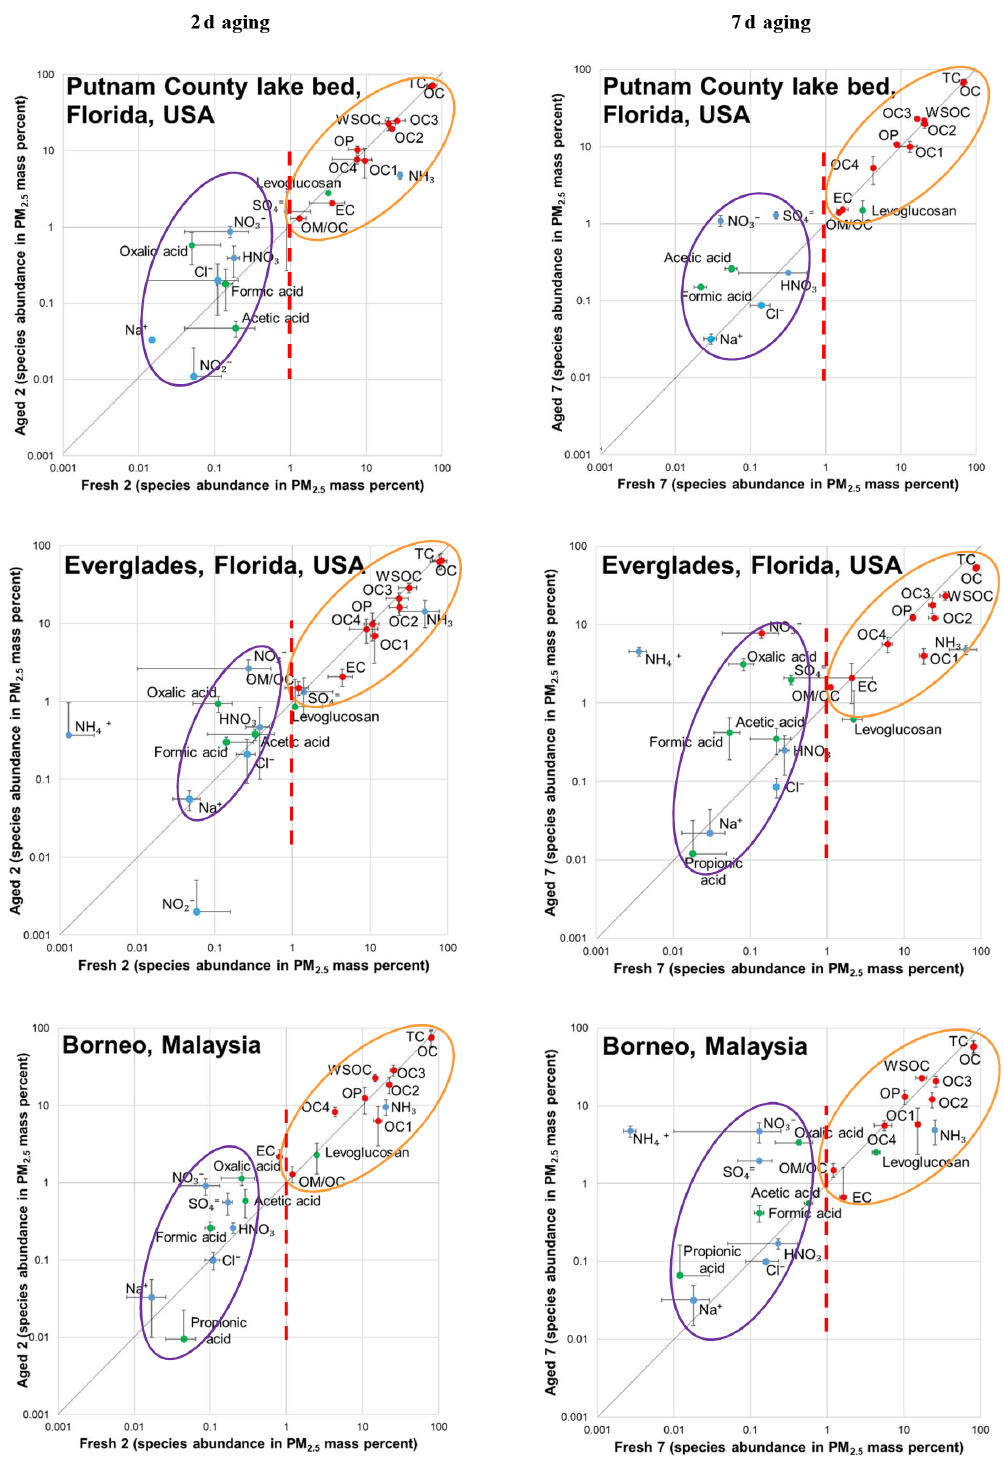
Figure 2. Comparison between fresh and aged profile chemical abundances for each of the six types of peat with 2 and 7d aging times. Standard deviations associated with averages for x and y variables are also shown. Vertical dashed lines (red) at 1% on the x axis delineate the two distinguishable clusters: centered around 0.1% for reactive and ionic species and centered around 10% for carbon